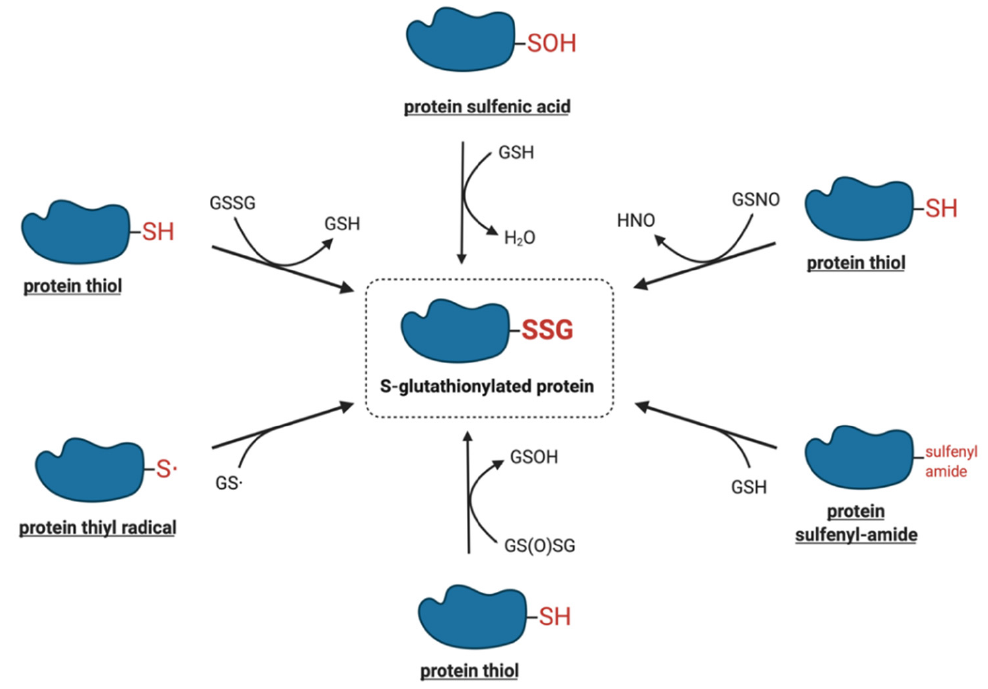
Figure 2. Proposed molecular mechanisms of S-glutathionylation.